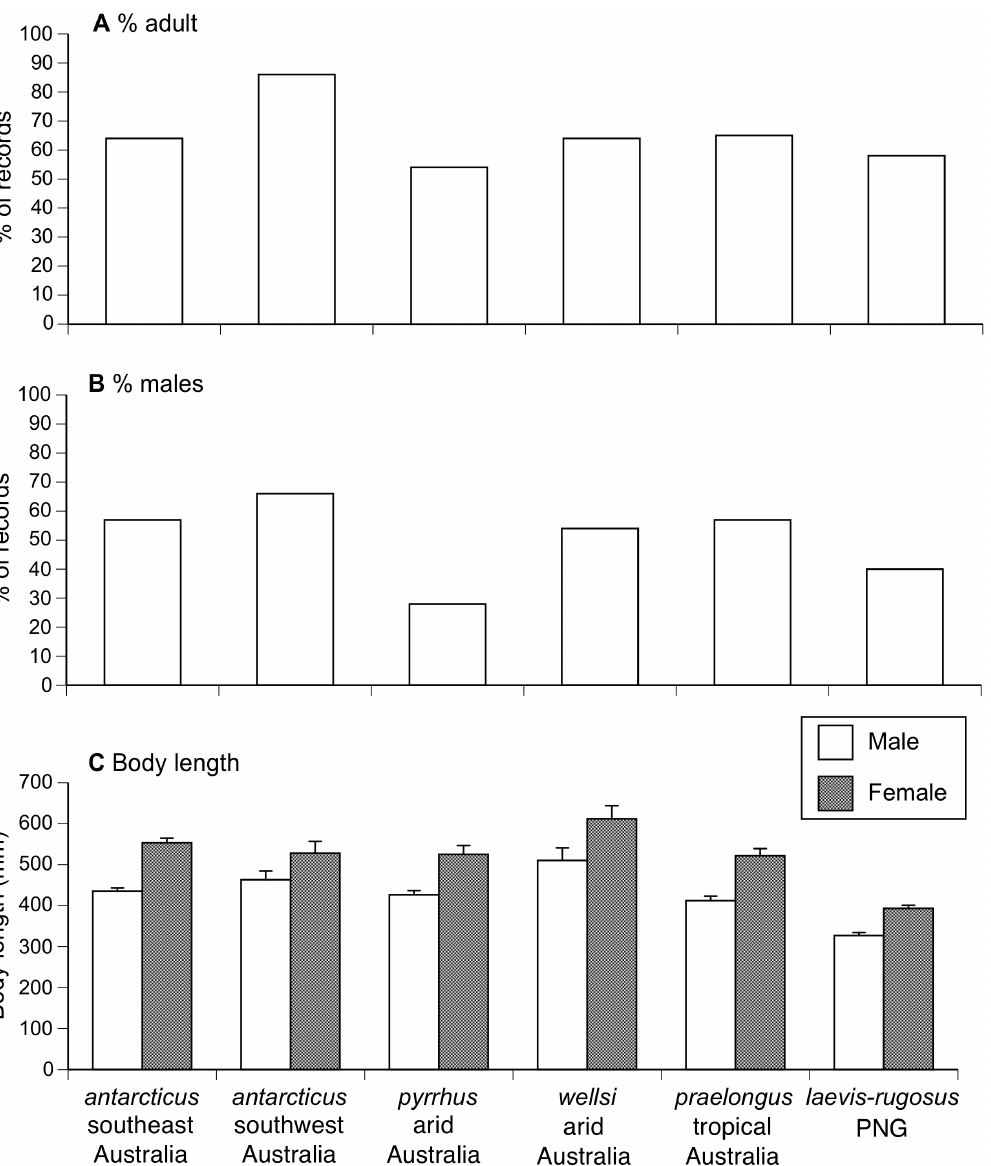
Figure 2. Interspecific variation in population structure and sexual size dimorphism in museum specimens of death adders (genus Acanthophis ). The panels show (A) the proportion of juvenile animals, (B) the sex ratio of adult animals, and (C) mean adult snout-vent lengths of males and females. Graphs show mean values and associated standard errors.